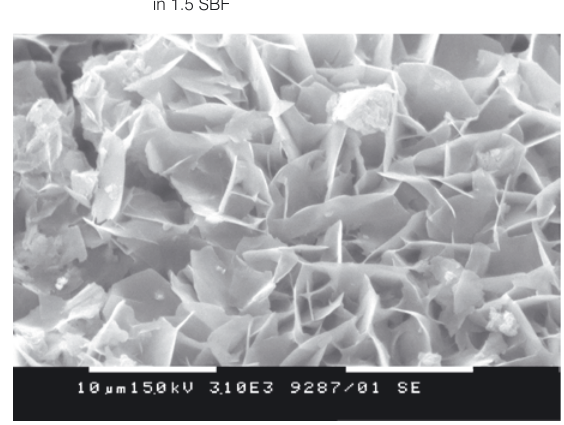
Figure 14. SEM of the G/S (25:75 wt.%) hybrid after immersion in 1.5 SBF